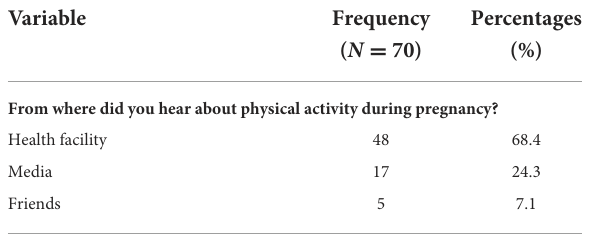
TABLE 3 Sources of knowledge of participants on physical activity.